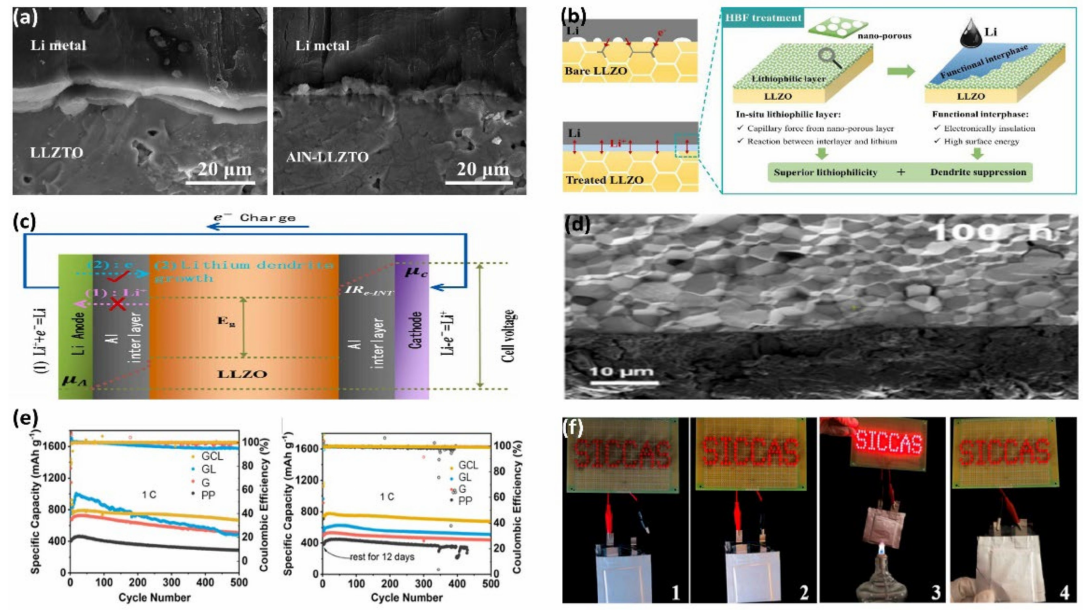
Figure 4. ( a ) SEM images of Li/LLZTO interface and ALN-LLZTO interface (Reprinted with per- mission from [58]; Copyright 2022, Nanomaterials (Basel)). ( b ) Schematic diagram of the interface between pure LLZO and LLZTO-Hb anode and description of the main functions of the lithophilic layer and the interface formed (Reprinted with permission from [59]; Copyright 2022, Energy Storage Materials). ( c ) Lithium dendrite inhibition mechanism of Li-conducting and electron-non-conducting Li-Al-O interlayers (Reprinted with permission from [61]; Copyright 2022, Journal of Alloys and Com- pounds). ( d ) Out-of-situ SEM images of Li/Zn-Cu-LlZto-Zn-Cu/Li after 100 h cycling at 0.8 mA · cm − 2 initial cycling performance of PP, G, GL, and GCL LSB at 1 C and the cycling performance after